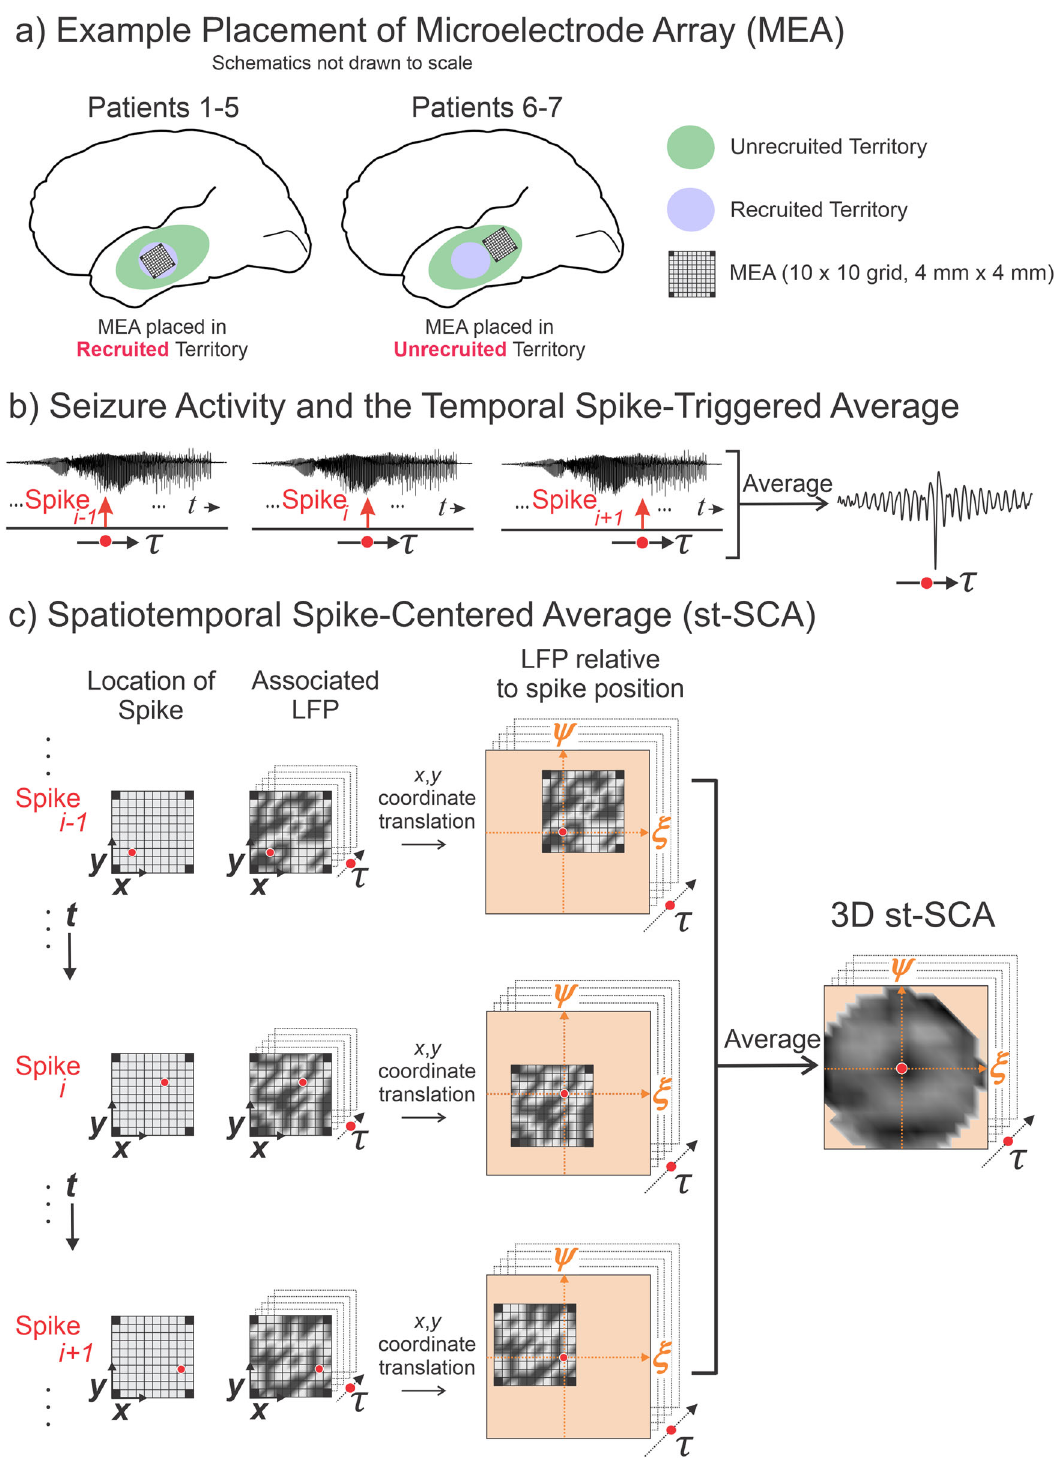
synaptic activity 3,12 . Both ictal and interictal recordings were evaluated, where interictal was de fi ned as being at least 2 h away from any known ictal activity. Filtering was used to extract local multi-unit neural fi ring activity and the associated low frequency component of the LFP of the surrounding network (Methods). Representative ictal and interictal signals and STAs calculated across ictal and interictal states for two recruited territory recordings and one unrecruited territory recording are depicted in Fig. 3. The black lines in Fig. 3c – h represent the STAs, the red